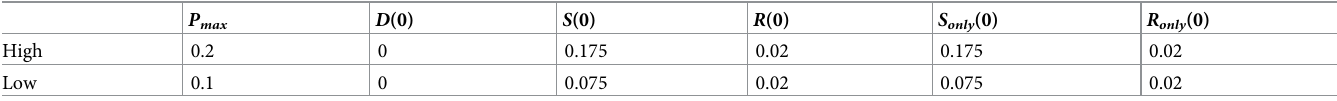
Table 2. Initial optical densities for simulations and